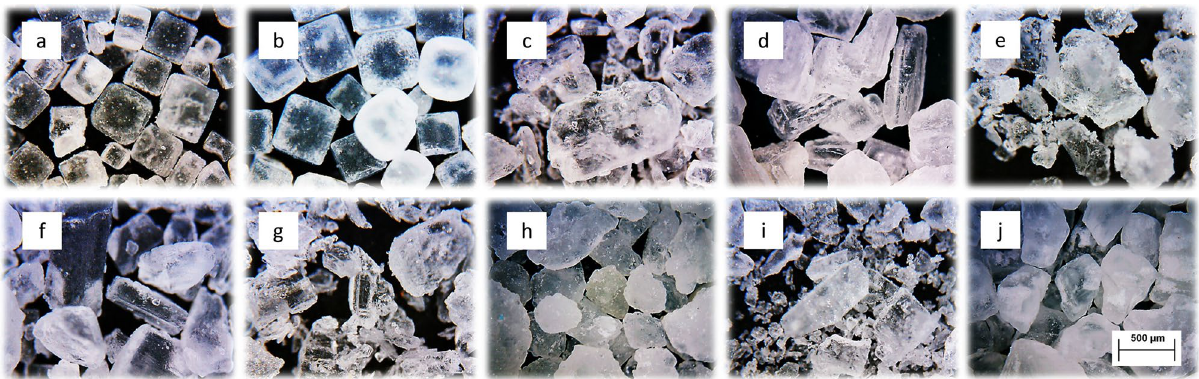
Figure 5. View of the grains of the measured salt samples, ( a ) edible iodized salt, ( b ) pure natural salt, ( c ) fine sea salt, ( d ) coarse-grained sea salt, ( e ) Sicilian fine salt, ( f ) dehydrated sea salt, ( g ) fine coastal sea salt, ( h ) Sicilian coarse-grained salt, ( i ) edible stone salt, ( j ) Italian coarse-grained sea